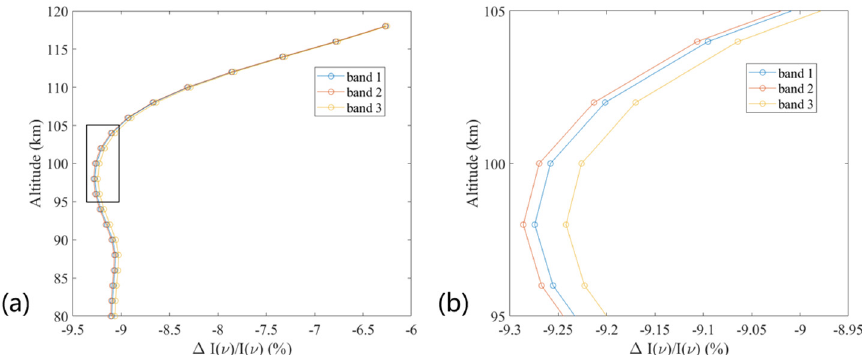
Figure 6. Response of spectrum of each target band to temperature perturbation. Where, ( b ) is the partial enlarged drawing of 95–105 km for ( a ). partial enlarged drawing of 95–105 km for ( a